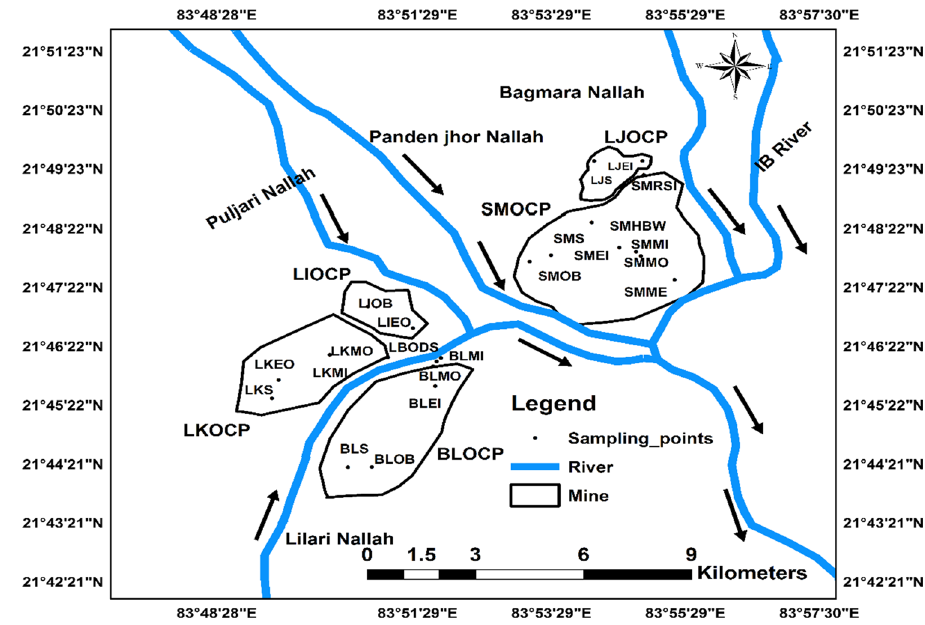
Fig. 4 Map showing Ib valley area with location of sampling